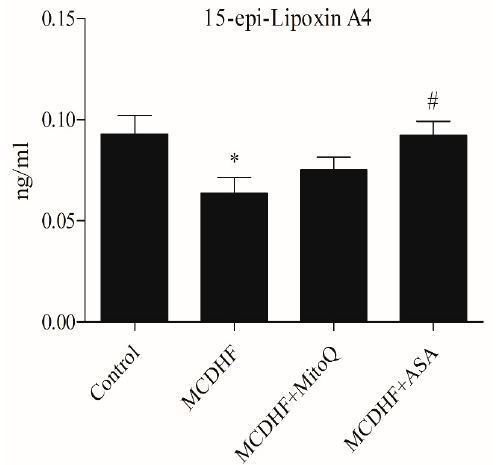
Figure 6. Liver 15-Epi-lipoxin A4 levels in control, MCDHF, MCDHF + MitoQ, and MCDHF + ASA mice. * p < 0.05 vs. control; # p < 0.05 vs. MCDHF. In MCDHFD animals, hepatic levels of anti-inflammatory 15-epi-Lipoxin A4 were reduced; ASA, but not MitoQ, normalized the levels of 15-epi-Lipoxin A4 in